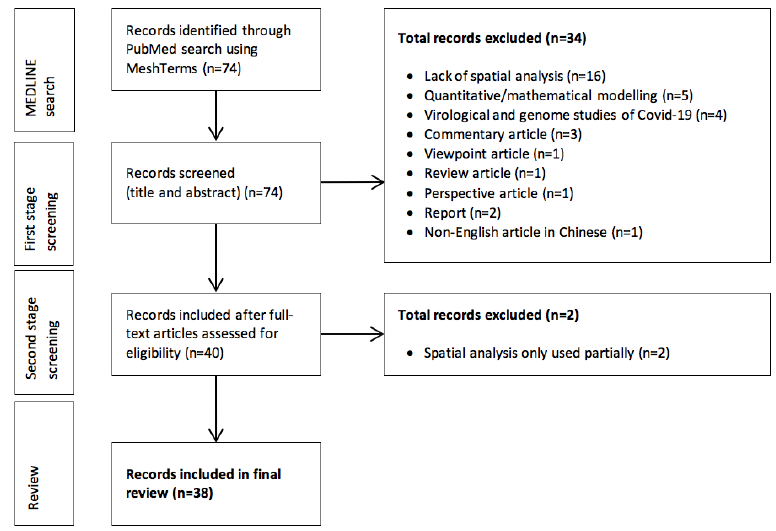
Figure 1. Flow chart showing the selection stages of the scoping review of spatial analysis used in COVID-19 studies (articles retrieved on 30 September 2020).